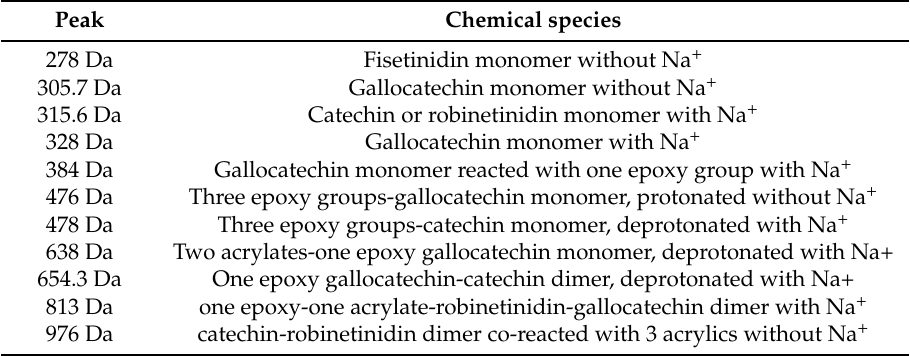
Table 2. Monomer and oligomer species observed from the MALDI spectrum of the ET3 epoxy tannin acrylic resin.